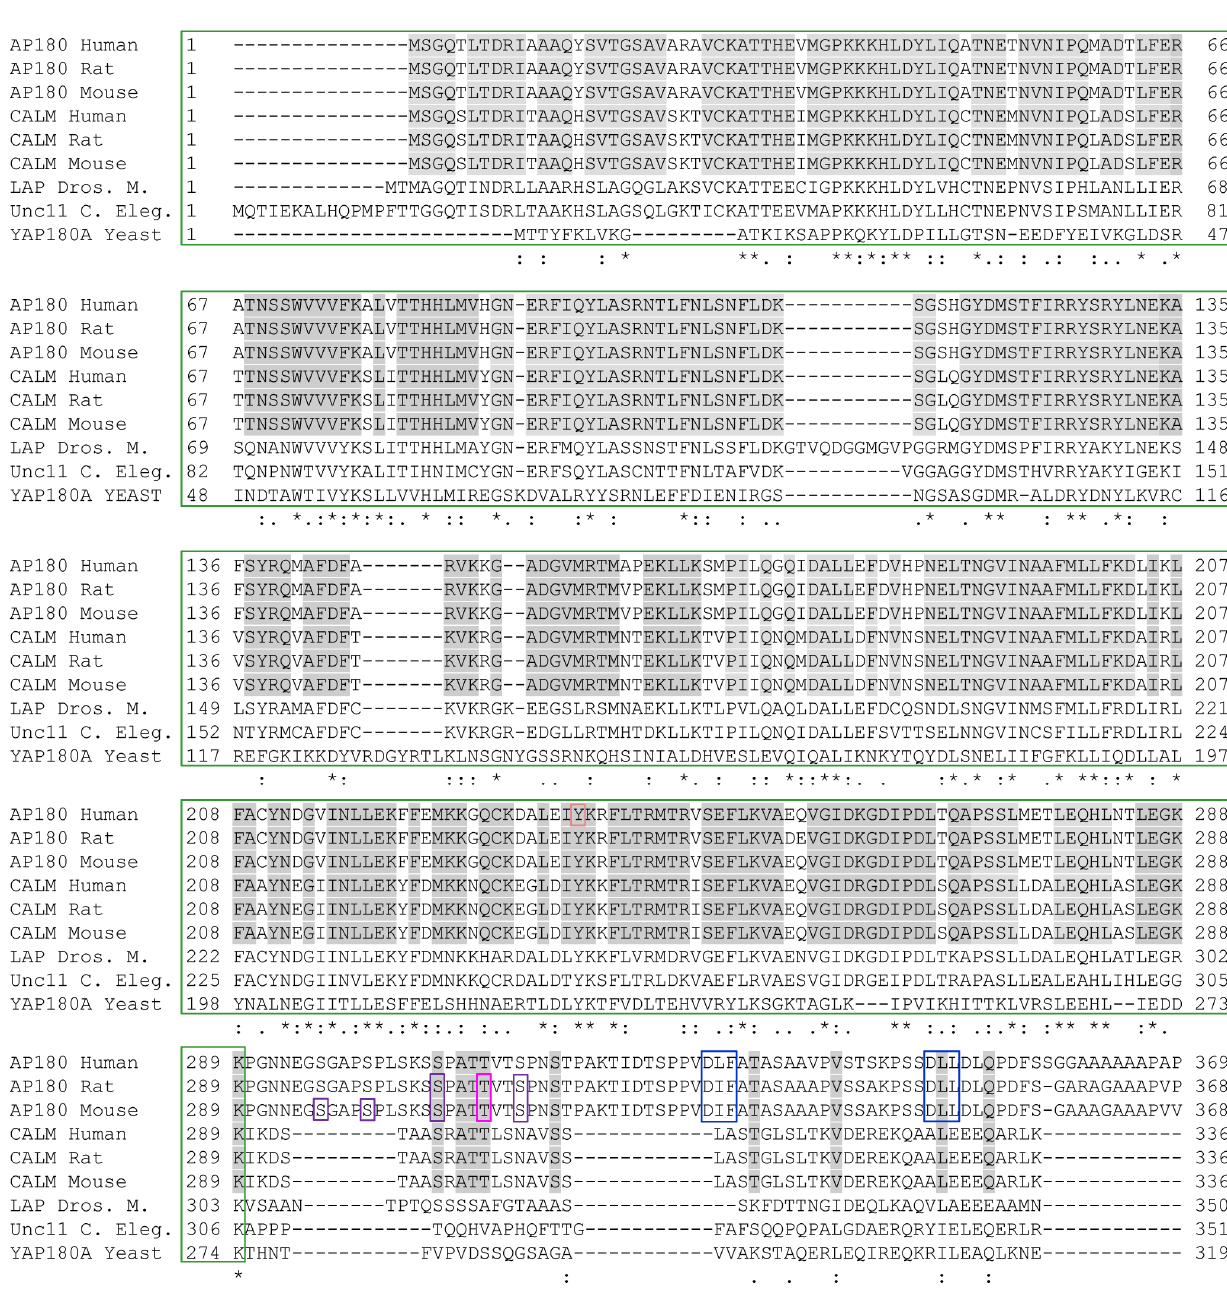
Figure 3. Alignment of isoform 1 of CALM and AP180 family members. Uniprot accessions: O60641, Q05140, Q61548, Q13492, Q498N4, Q7M6Y3, Q9VI75, Q9XZI6 and P38856. Domains, motifs and post-translational modifications are boxed using Figure 2 color scheme, except that all CLAP motifs are blue and O-GlcNAc-P (AP180 only) and O-GlcNAc (CALM) are pink. Identical residues in mammalian CALM and AP180 are shaded grey. Similarity across commonly researched organisms are indicated below: “*”, identical; “:”, strong similarity; “.”, weak similarity. Only phosphosites listed at PhosphoSite.org with ≥ 3 journal article references, or manually verified by our group [45] are